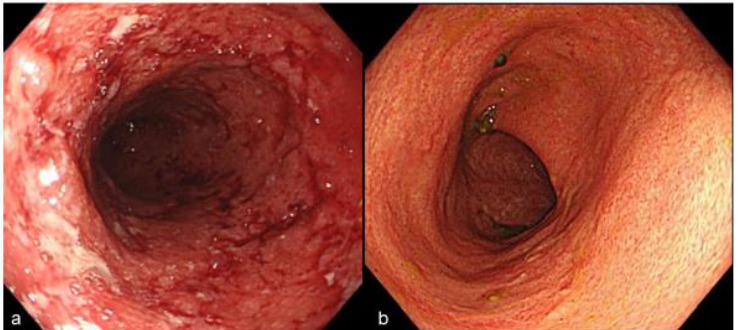
Figure 2. Colonoscopic images before ( a ) and after ( b ) treatment. Diffuse continuous rough-surfaced mucosa was observed in the sigmoid colon. Adherent mucous, redness, and blood clots were seen ( a ). Smooth-surface mucosa was observed in the sigmoid colon. Active findings before treatment were no longer seen ( b ). The physical examination was non-contributory. Anal fistula and anal skin tags were absent. He was tentatively diagnosed with severe UC due to his history, mild anemia (he- moglobin 12.1 g/dL), hypoalbuminemia (3.5 g/dL), increased C-reactive protein (CRP) (5.13 mg/dL) (ref erence range ≤ 0.14) and elevated erythrocyte sedimentation rate (ESR) (47 mm/h) (reference range ≤ 10). The fecal immunochemical test was more than 1000 ng/mL (reference range ≤ 100). IPF therapy with 300 mg of infliximab and 800 kcal of plant -